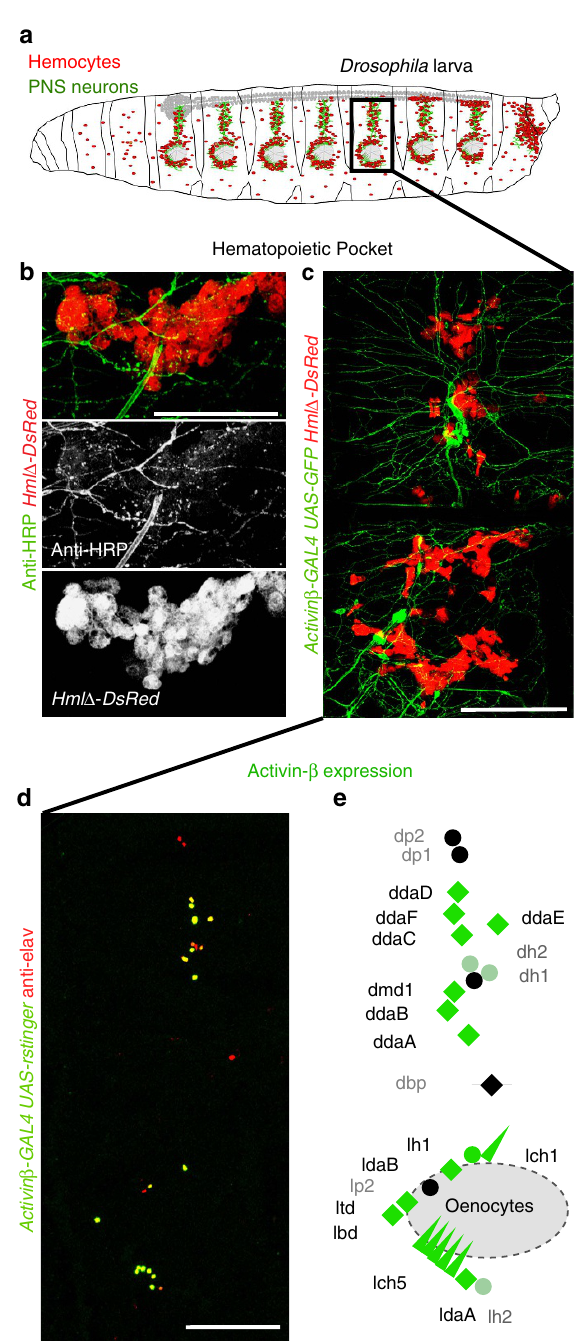
Figure 1 | PNS sensory neurons produce Activin- b and are surrounded by hemocytes. ( a ) Model of a Drosophila larva; hemocytes in red, neurons in green. Boxed area marks a HP. ( b ) Close-up of a lower part of a HP illustrating intricate neuronal extensions in areas of hemocytes; neurons (Anti-HRP, green), hemocytes ( Hml D -DsRed , red), lateral patch area. Middle and lower panel show single channels. ( c ) Act b expressing larval PNS neurons marked by reporter Act b -GAL4; UAS-mCD8GFP (green), Act b positive neurons colocalize with hemocytes marked by Hml D -DsRed (red). Fillet prep containing all tissue layers. ( d ) Act b expression pattern in larval PNS neurons, Act b - GAL4/ þ ; UAS-r-stinger/ þ (green), pan-neuronal anti-elav (red). Fillet prep containing all tissue layers. ( e ) Model of Act b expression (green) in most multidendritic neurons (diamonds), chordotonal organs (triangles), and some external sensory neurons (circles). Scale bars, b , 50 m m; c , d , 100 m m.